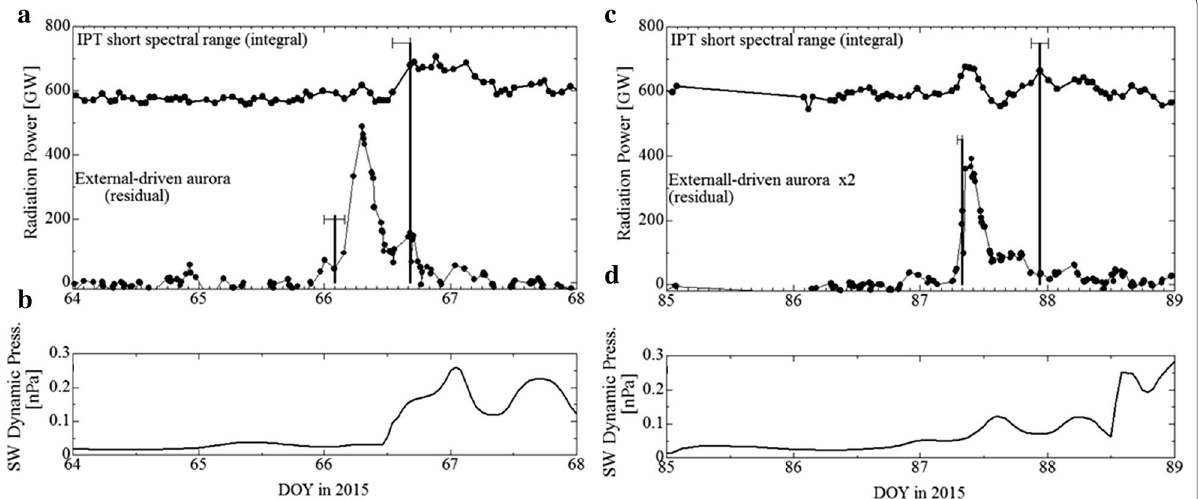
Fig. 7 a , c Aurora and IPT brightenings on DOY 66 and 87, respectively. The format is the same as that in Fig. 5. b , d Predictions of the dynamic SW